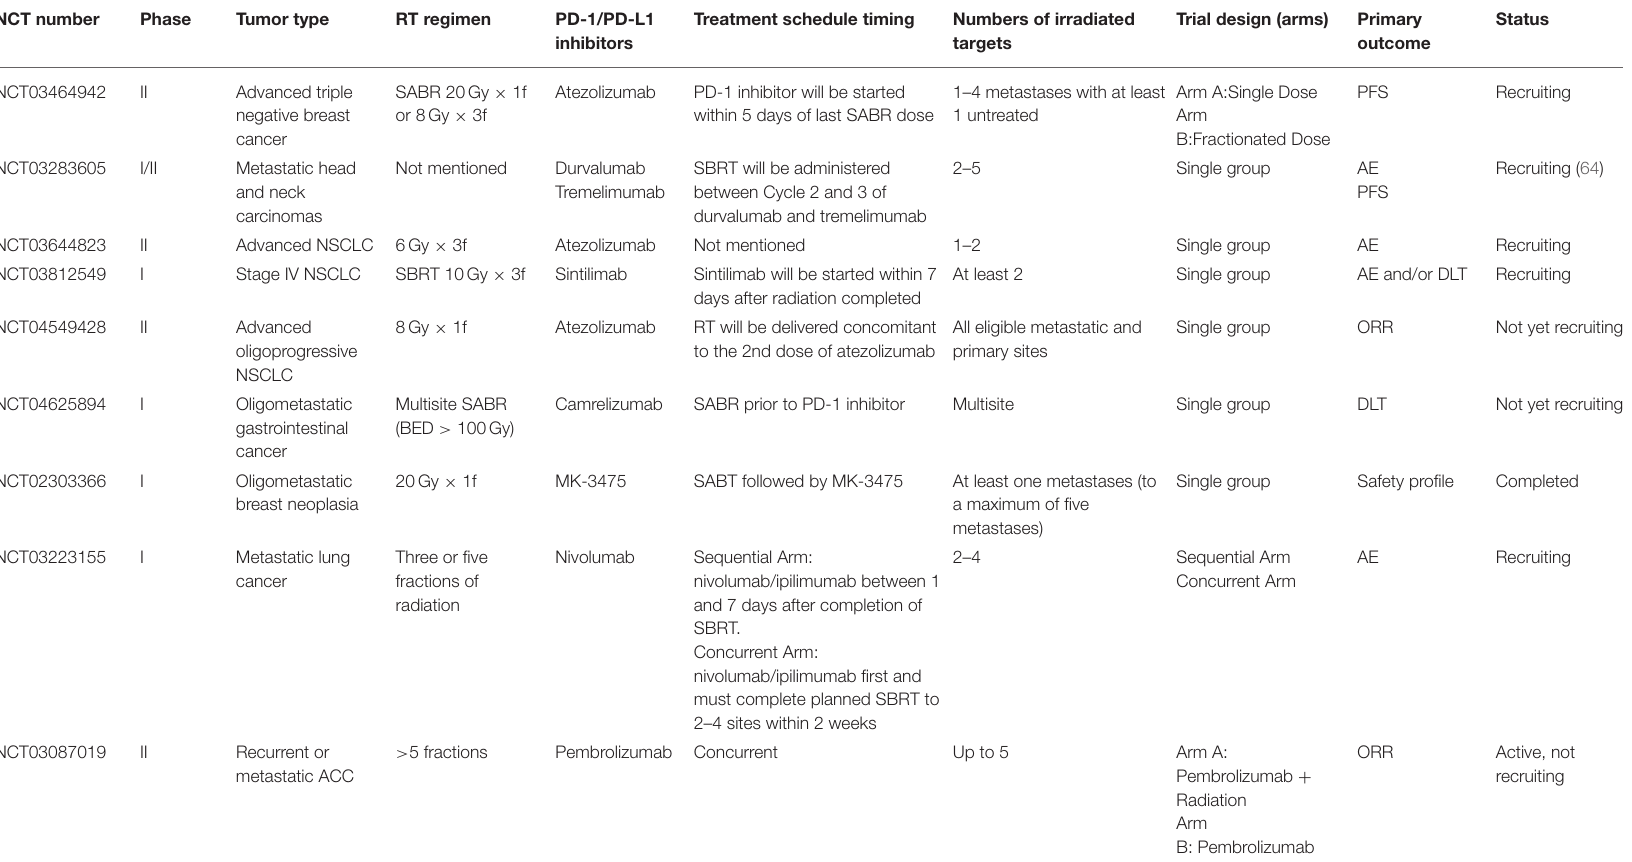
TABLE 2 | Trials testing radiotherapy in combination with PD-1/PD-L1 in advanced metastatic cancers that allowed more than one irradiated